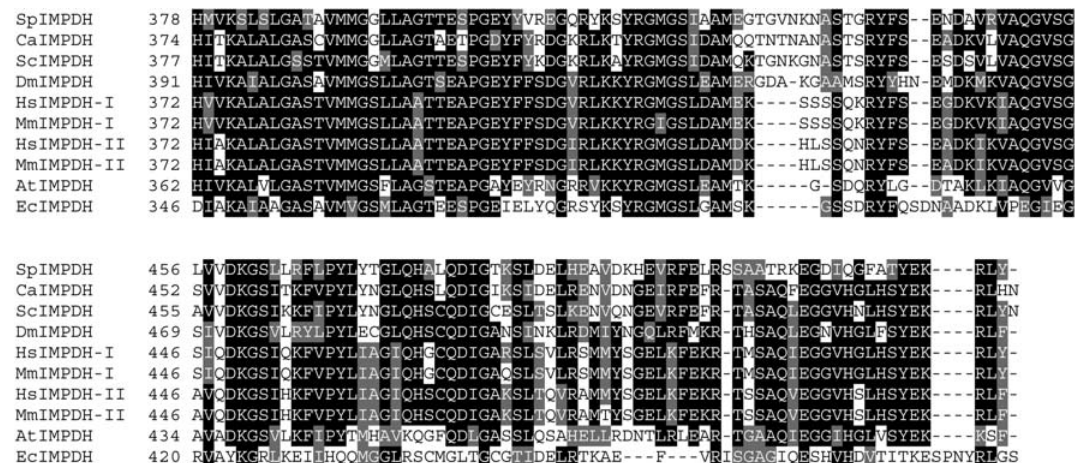
Figure4 -Partialaminoacidalignmentof Schizosaccharomycespombe inosinemonophosphatedehydrogenase(IMPDH)(GenBankCAB97003)homo- logues with Candida albicans (O00086), Saccharomyces cerevisiae (P50094), Drosophila melanogaster (Q07152) Human type I (P20839), Mus musculus (P50096), Human type II (P12268), M. musculus type II (P24547), Arabidopsis thaliana (Q9SA34) and Escherichia coli (P06981). Abbrevia- tions for the species are: Sp = S. pombe ; Ca = C. albicans ; Sc = S. cerevisiae ; Dm = D. melanogaster ; Hs = Homo sapiens ; Mm = M. musculus ; At = A. thaliana ;Ec= E.coli .Identicalaminoacidsareshownwithablackbackground,similaraminoacidswithagraybackground.Dashes(gaps)havebeenin- troduced for optimal alignment. The alignments revealed that the regions of putative catalytic domain amino acids (378-524) were highly